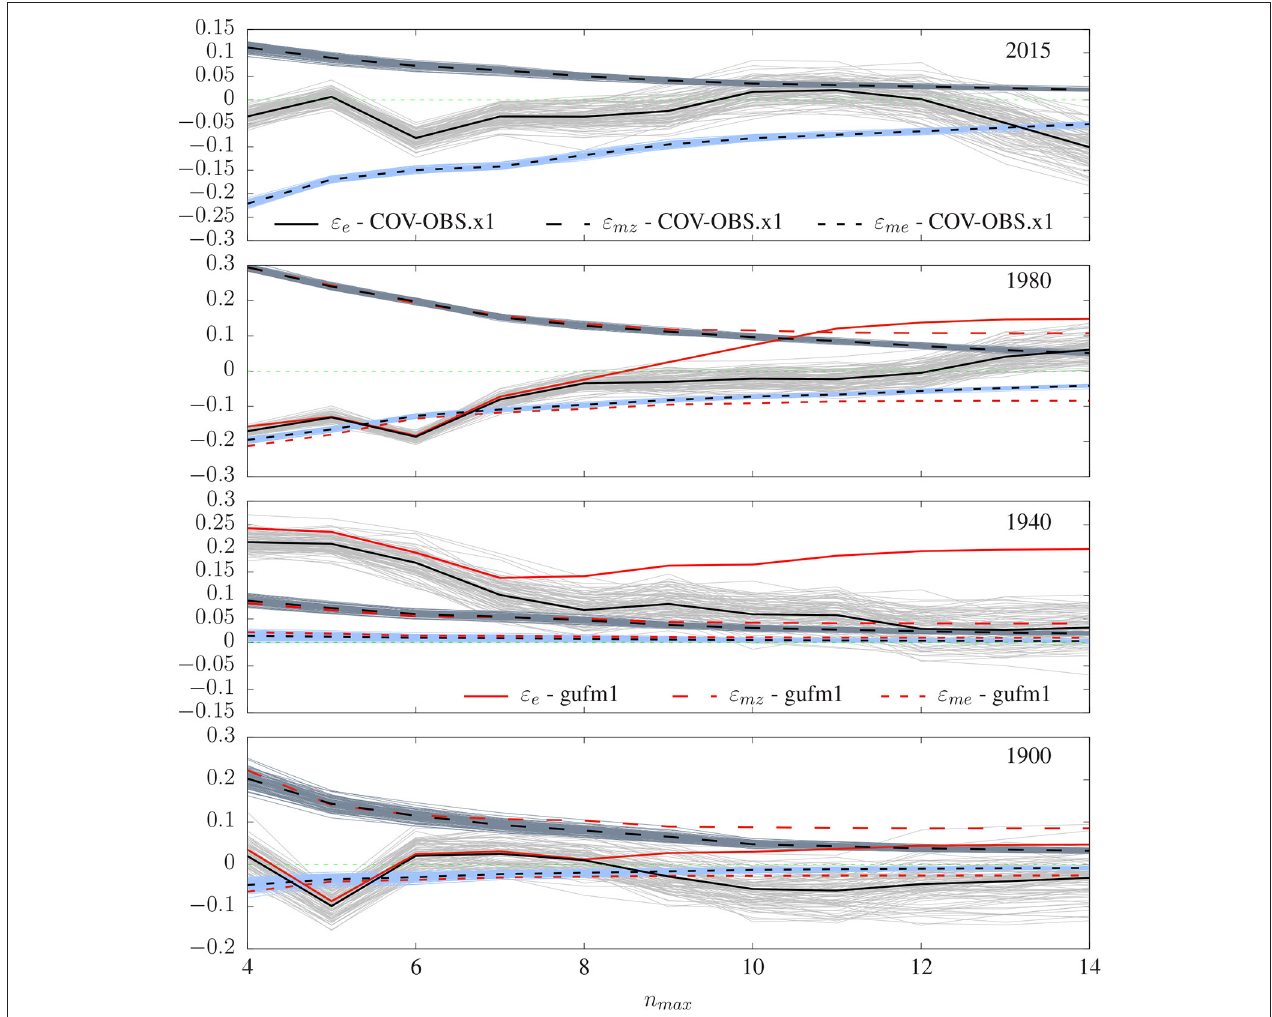
FIGURE 7 | Ratios ε e (solid lines), ε mz (dashed lines), and ε me (dotted lines) as a function of n max for four snapshots using gufm1 (red, Jackson et al., 2000) and the mean of COV-OBS.x1 (black, Gillet et al., 2015). The family of 100 COV-OBS.x1 models is presented in light, dark gray, and light blue lines for ε e , ε mz and ε me , respectively. Green line denotes the zero